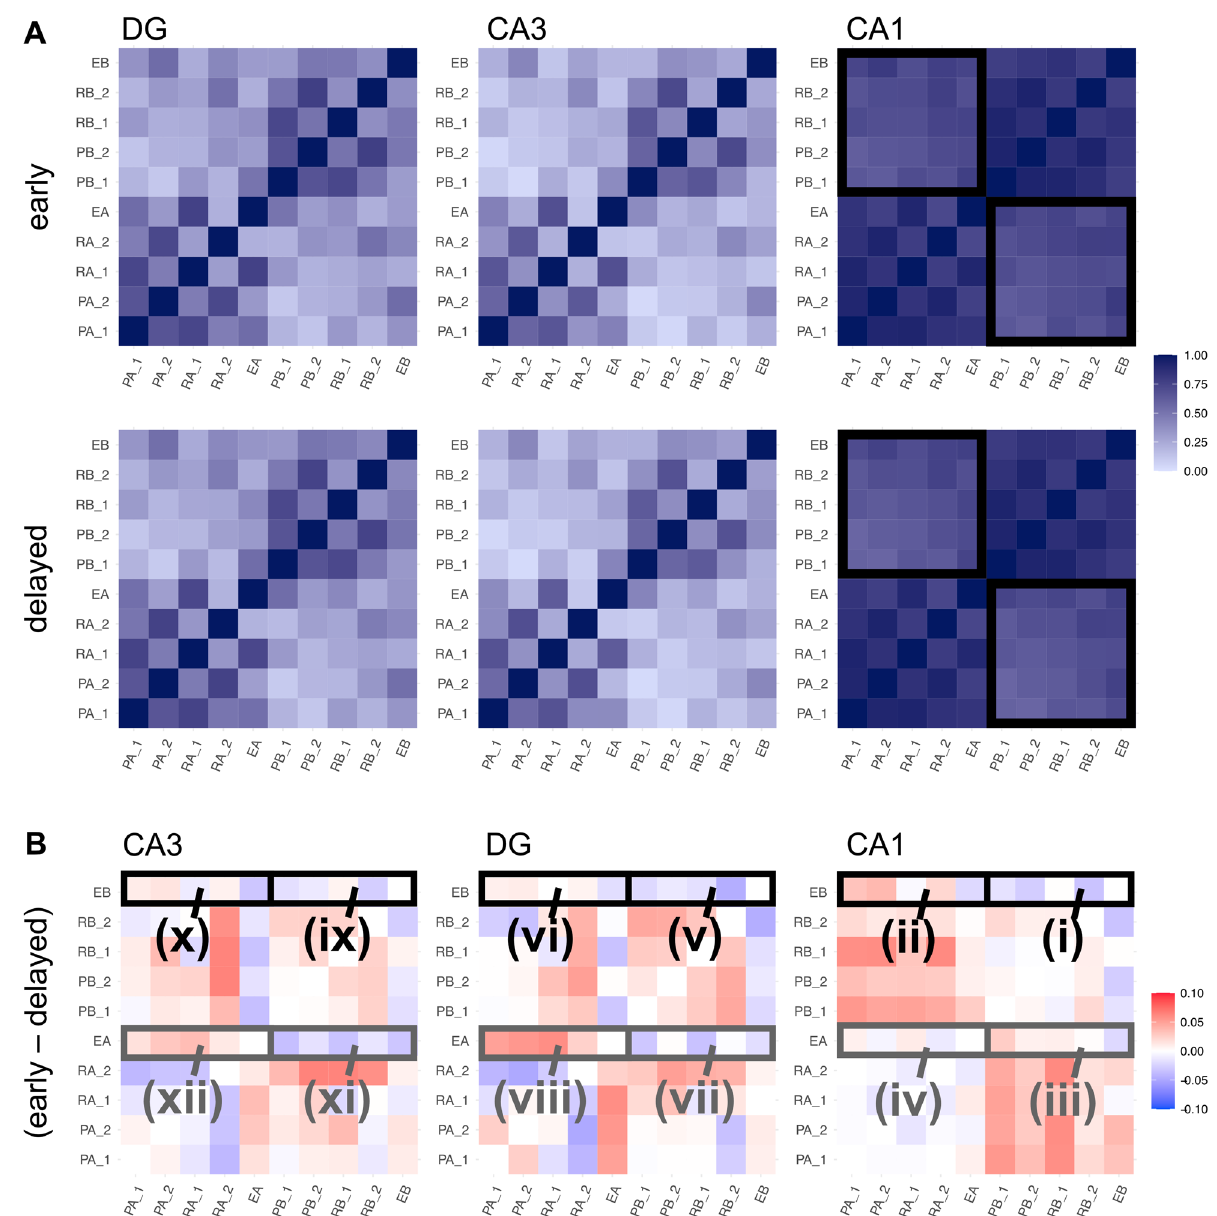
Figure 5. ( A ) Representational similarity analysis results, separated by condition and subfield. Rows and columns correspond to the 10 stimuli. Darker shades indicate higher similarity. In all subfields, higher intra- versus intercategory similarity is apparent. Category bounds are indicated in black in the CA1 grid. ( B ) The difference in representational similarity across conditions (early minus delayed). Red indicates higher similarity in the early condition; blue, higher similarity in the delayed condition. The red colour of the upper left and lower right quadrants of the rightmost plot indicates higher intercategory similarity in CA1 in the early compared to the delayed condition. Differences in exception representation are evident throughout the three subfields. EA is generally more similar to its own category members in the early condition and more similar to opposing category items in the delayed condition (these comparisons are outlined in grey), whereas EB is more similar to its own category members in the delayed condition and more similar to members of the opposite category in the early condition (outlined in